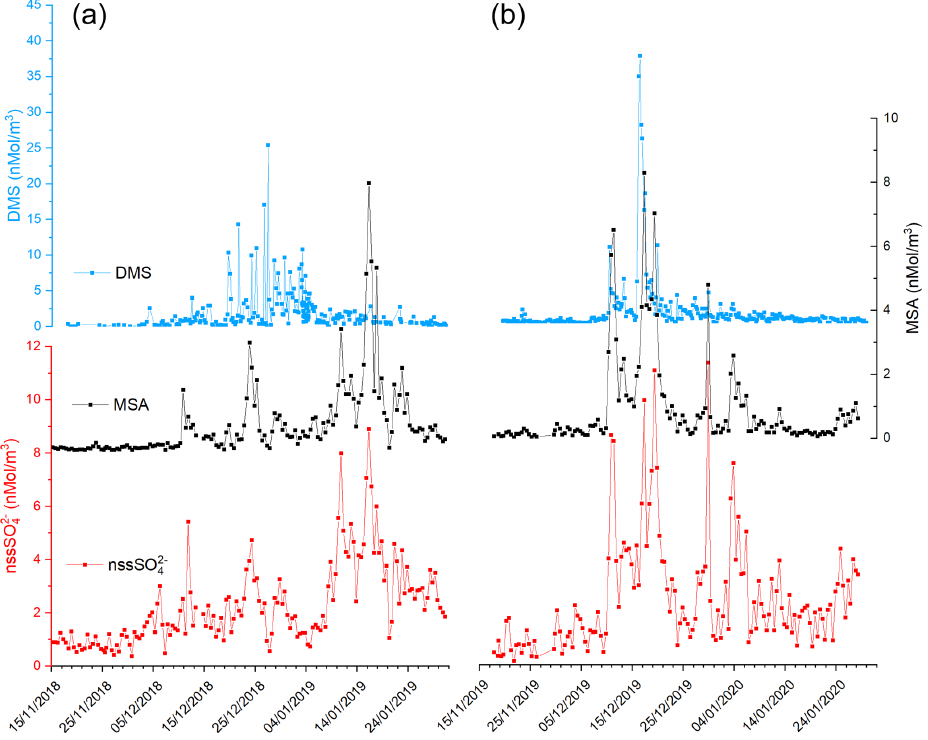
− in the two AC: 2018–2019 (plots in a ) and 2019–2020 (plot in b 4